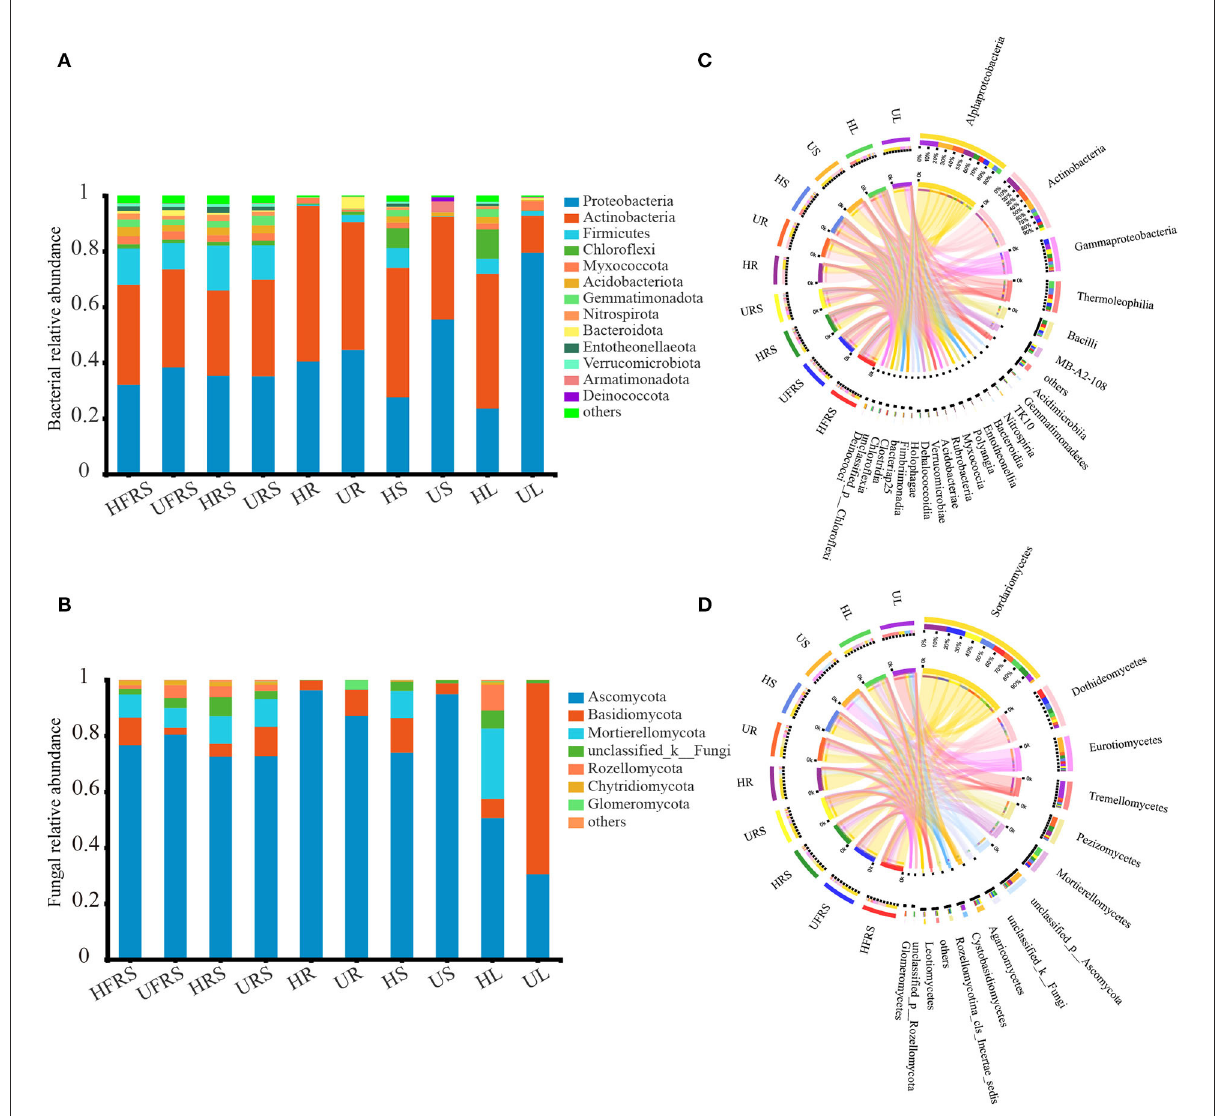
FIGURE3 Phylum and class distributions of the OTUs. Relative sequence abundance of (A) bacterial and (B) fungal phyla associated with the soil (rhizospheric and bulk soil), and different plant compartments (roots, stems, and leaves) of healthy and unhealthy P. bungeana plants. The Circos plot depicts the distribution proportion of core (C) bacterial and (D) fungal classes in soil samples and different compartments of healthy and unhealthy P. bungeana plants. The core represents the microbes with major contributions. The Circos plot depicts the proportion of core microbiota in each compartment and reflects the proportion of each dominant species in different samples. The thickness of the ribbons in the Circos plots thickness represents the abundance of the taxon. The absolute tick above the inner segment and relative tick above the outer segment represent the read abundances and relative abundances of the taxa, respectively. Abbreviations of variables are given in Figure